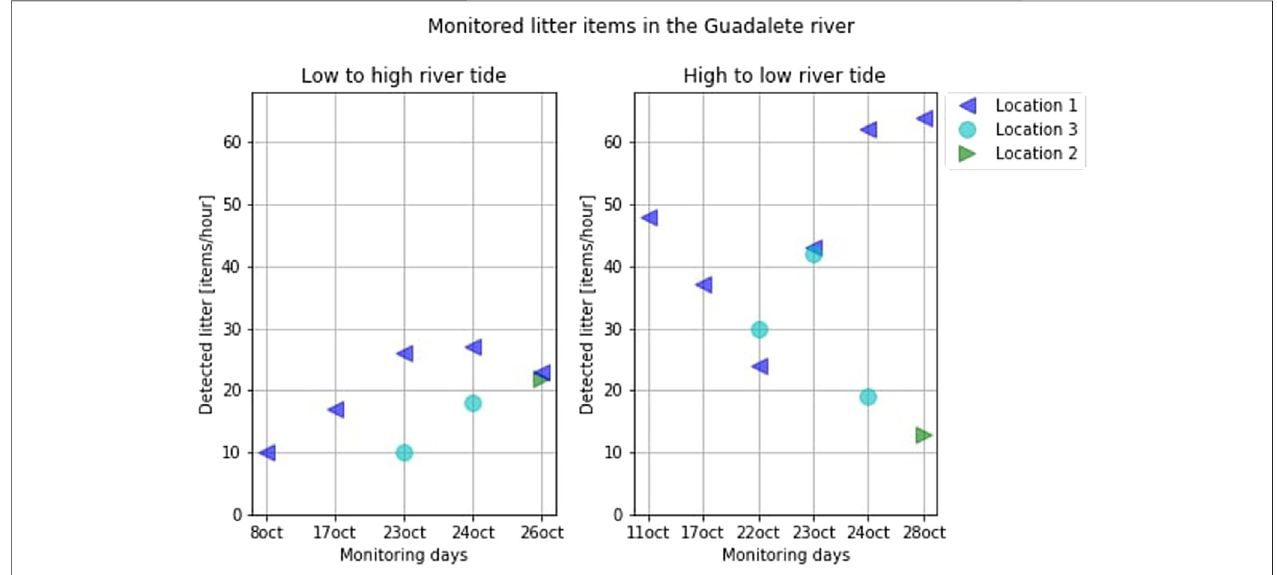
FIGURE8| Totalmonitoreditemsduringthe fi eldcampaignusingthewidescanningbeam(47 ° ),forthethreedifferentlocationsovertheriver ’ scross-section.Left: monitoreditemsforriverwaterlevelgoingfromlowtohigh(water fl owsfromtheseainland).Right:monitoreditemsforriverwaterlevelgoingfromhightolow(water fl ows from inland towards